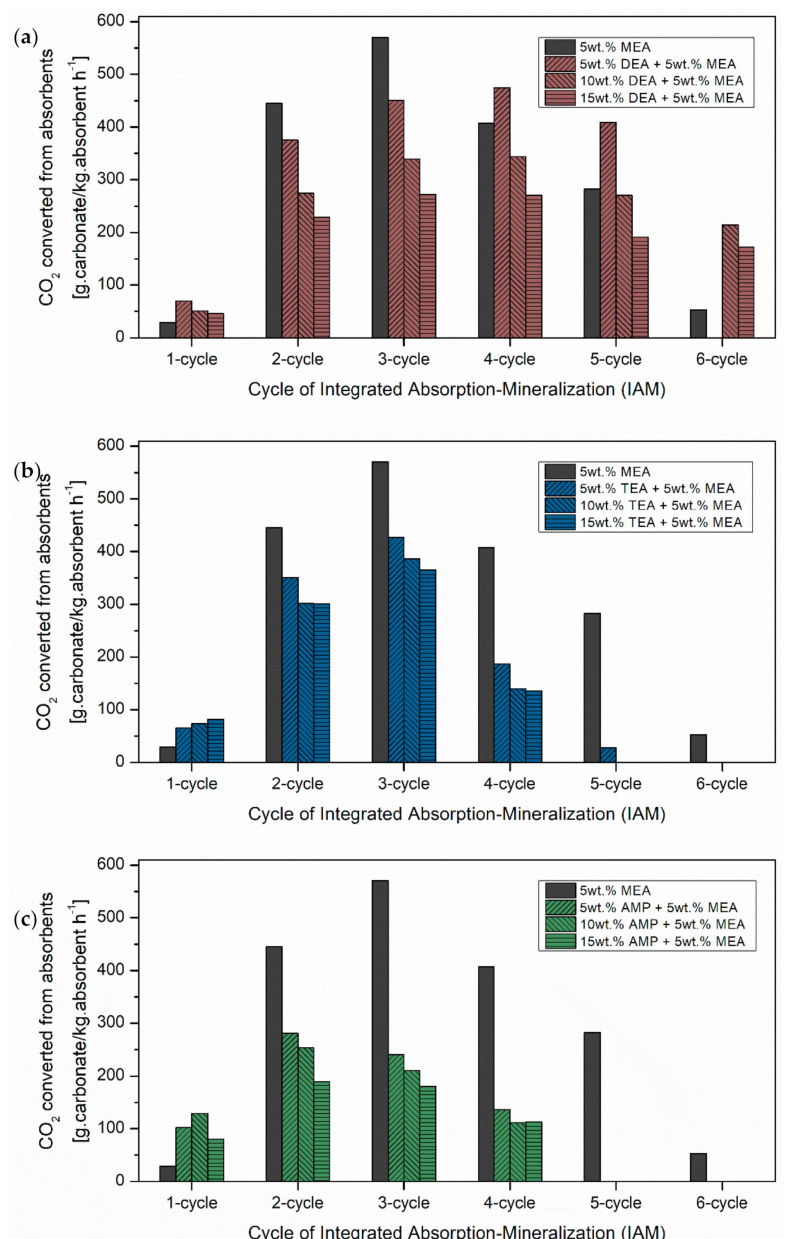
Figure 3. The CO 2 conversion from blended alkanolamine absorbents in each cycle of multicycle integrated absorption–mineralization (IAM) was evaluated as a function of the absorption time for monoethanolamine (MEA)-blended ( a ) diethanolamine (DEA), ( b ) triethanolamine (TEA), and ( c ) aminomethyl propanol